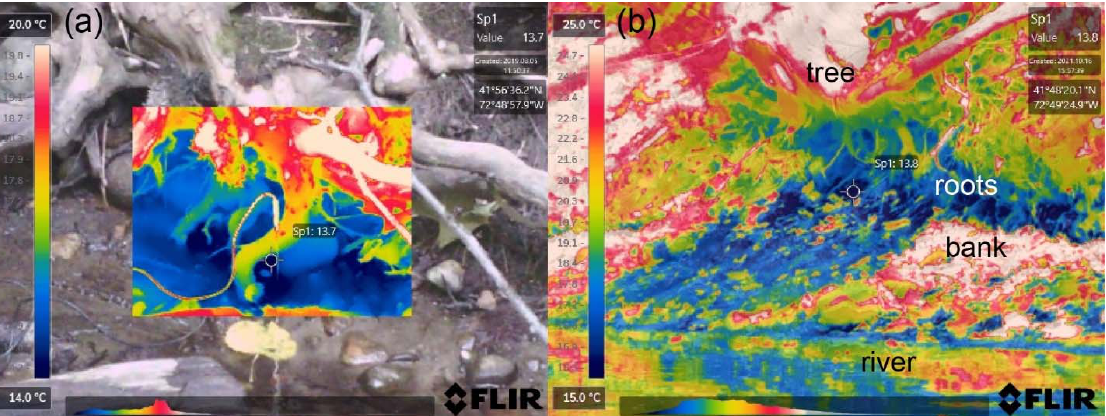
Figure 3. Preferential groundwater discharge directly associated with tree roots protruding from the bank along a ( a ) third-order, and ( b ) fifth-order stream section in the Farmington River watershed. The coldest discharge temperature at bank surface indicated by IR imaging within the field of view was similar at both sites at approximately 13.7 °C.